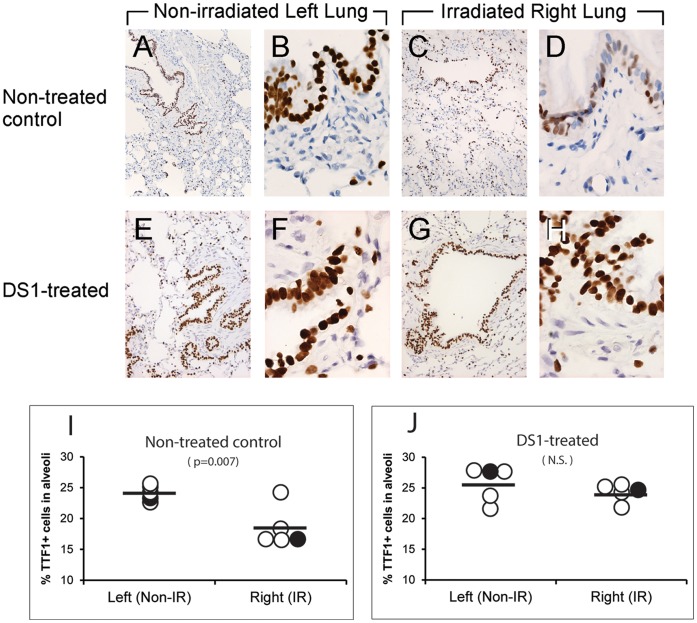
Immune histochemistry and quantitation of TTF-1+ cells in bronchioles of a non-treated control dog (Panels A to D) and a DS1-treated dog (Panels E and H) at necropsy (week 26).Two columns on the left are from non-irradiated left lungs; two columns on the right are from irradiated right lungs. TTF-1 was detected brown with HRP-conjugated antibodies and DAB as a chromogen. Nuclei were counterstained with hematoxylin (blue). Original objective X20 for Panels A, C, E and G; X100 for Panels B, D, F, and H. Panels I and J: The number of TTF-1+ cells in alveolar regions was quantified using HistoQuest software as described in Figure S2. The percentage of TTF-1+ cells in left and right lungs of the non-treated control dogs (n = 5) and DS1-treated dogs (n = 5) at necropsy (Week 26) are shown in Panels I and J, respectively. IR = irradiation. Horizontal bars indicate mean values. The solid circles indicate the values for the representative images shown in A and C for panel I, and E and G for panel J.